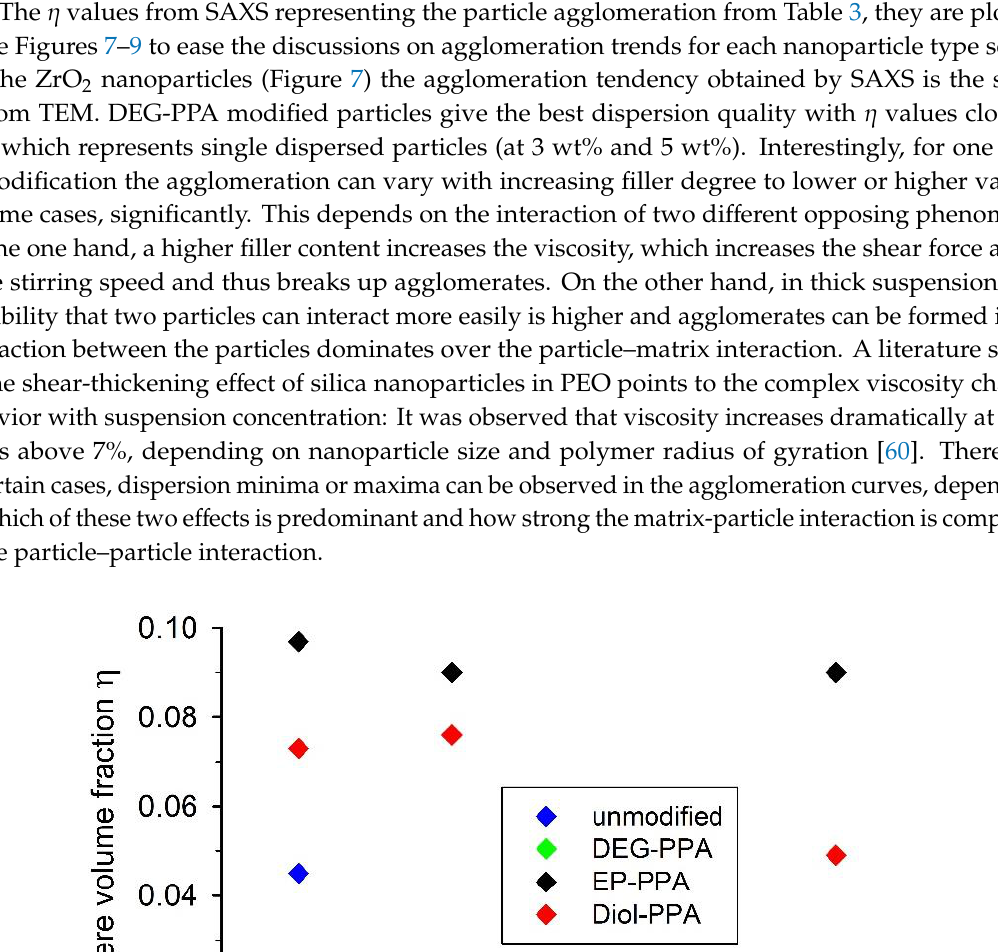
Figure 8. Hard sphere volume fraction of small SiO 2 nanoparticles with different surface modifications and incorporated into the epoxy resin matrix with different percentages.